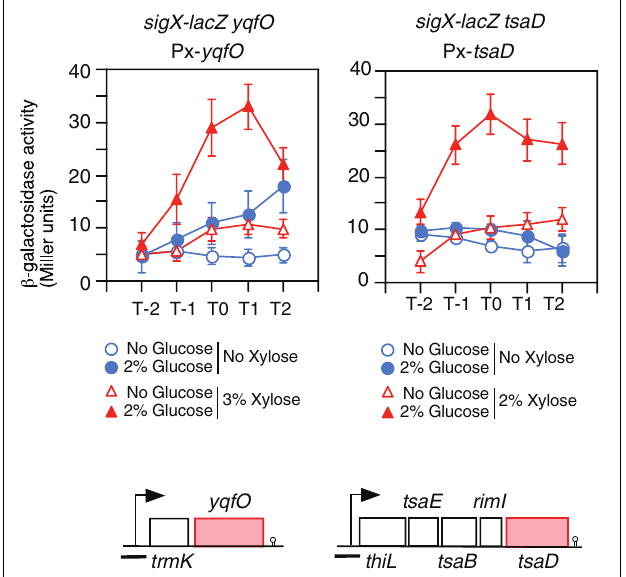
FIGURE 3 | Complementation of the GI of sigX-lacZ in each gene disruption mutant by artificial induction of the gene. Means of the β -Gal activities from three independent experiments and the standard deviations are shown. The x axis is the same as in the legend to Figure 1 . The relevant genotypes are indicated above the panel. Strains are as follows: left, OAM738; right, OAM739. The chromosomal structure of the operon containing the corresponding gene is shown under the panel. Boxes and bent arrows show open-reading frames and promoters, respectively. The gene names are shown along the boxes. The black bar shows the cloned promoter region for analyzing promoter expression.